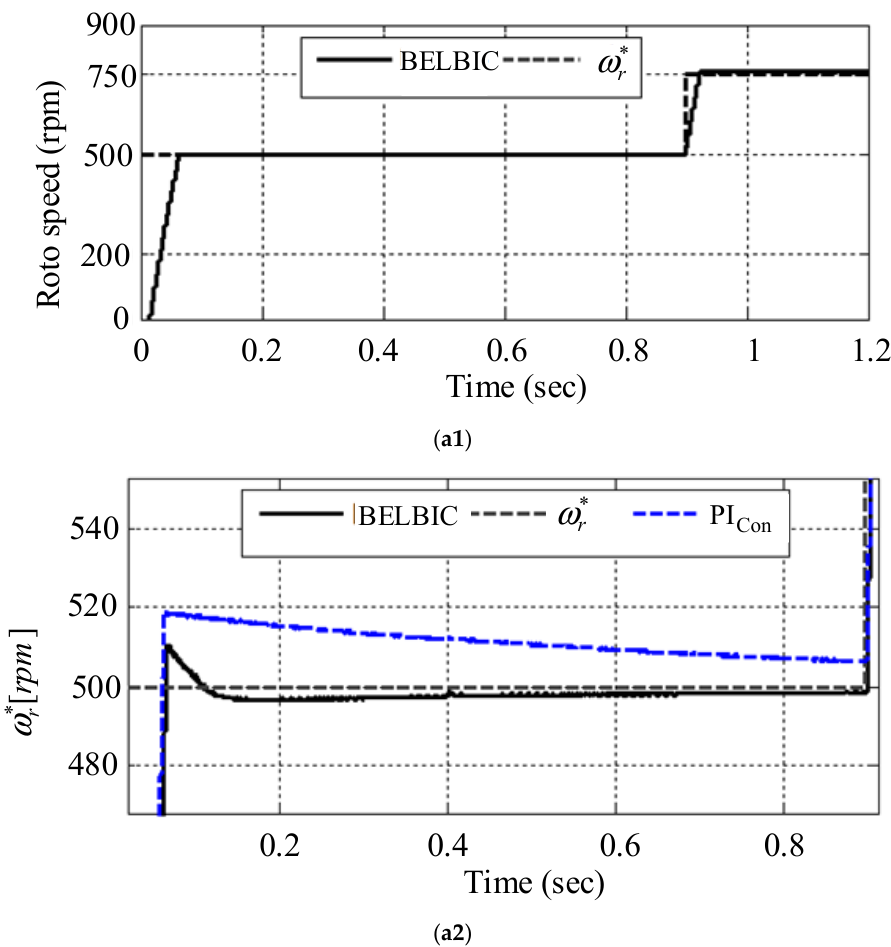
Figure 10. Speed and flux control using BELBIC and the conventional PI controller set with GA. ( a1 ) Rotor speed, ( a2 ) Rotor angular velocity.